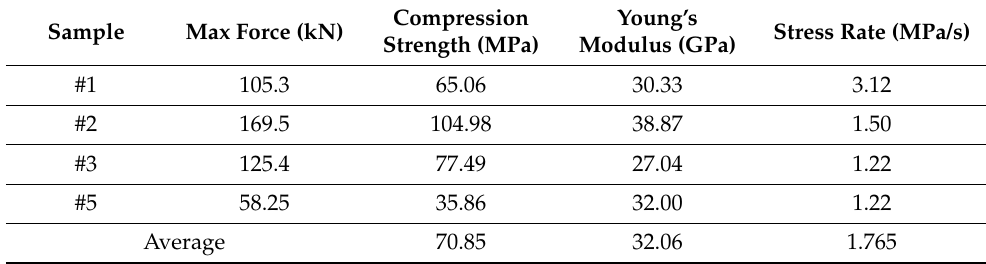
Table 2. Results of simple compression